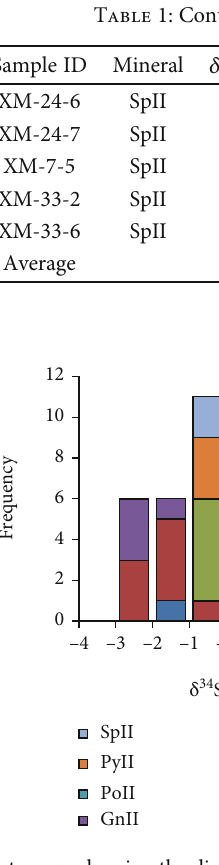
Figure 6: Histogram showing the distribution of measured δ 34 S for di ff erent mineralization stages at the Xinmin deposit.